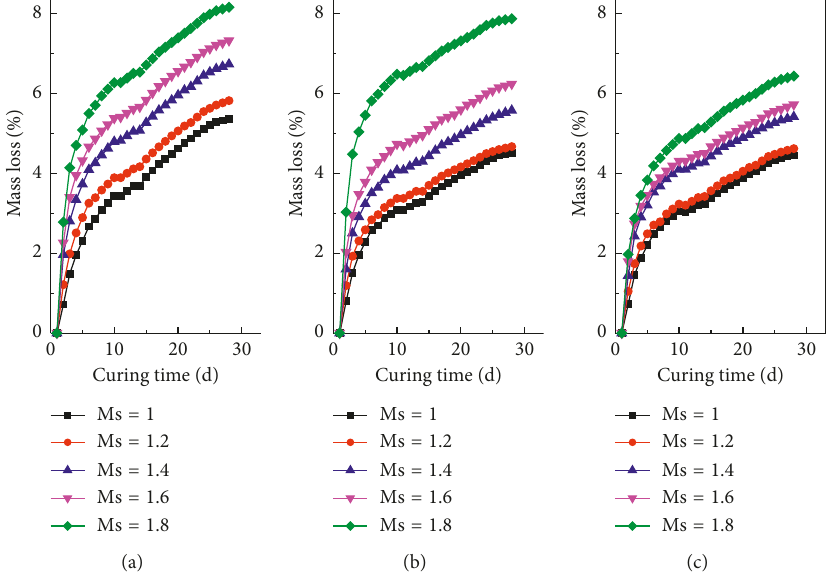
Figure 5: The effects of the silicate moduli and Na 2 O contents on the mass loss of AAS pastes. (a) 6% Na 2 O. (b) 8% Na 2 O. (c) 10% Na 2 O.